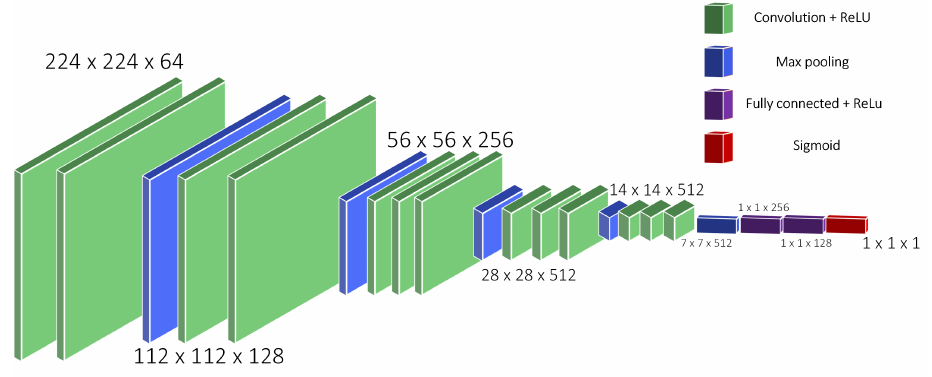
Figure 2. The structure of the VGG network used in our